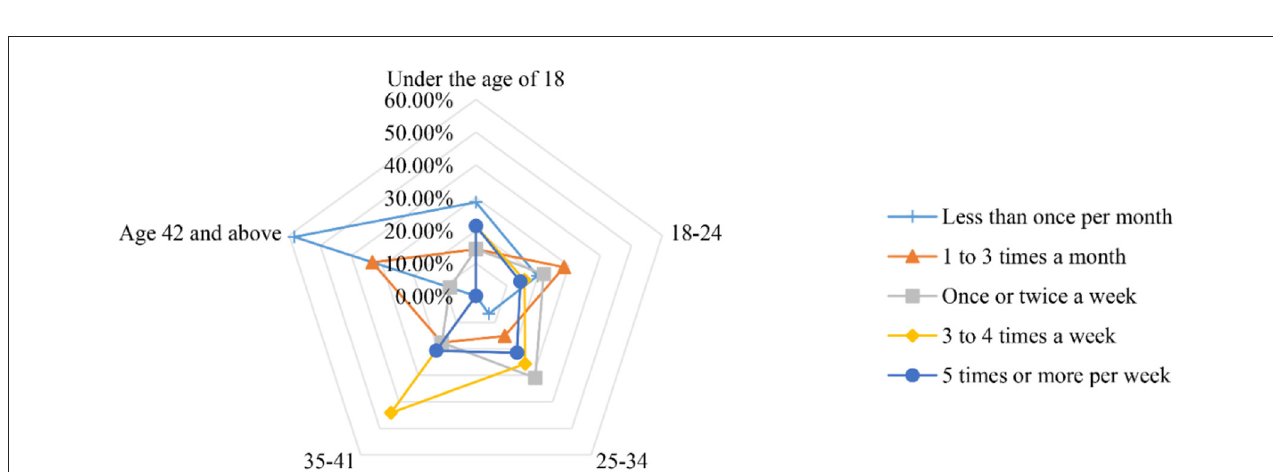
FIGURE8 Radar charts of the age group and frequency of use of ride-hailing services after the